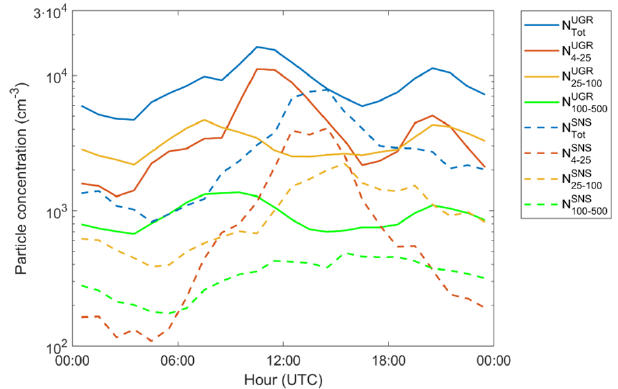
Figure 2. The mean diurnal variation of particle concentrations in different size ranges at SNS and UGR for the whole analysed pe-